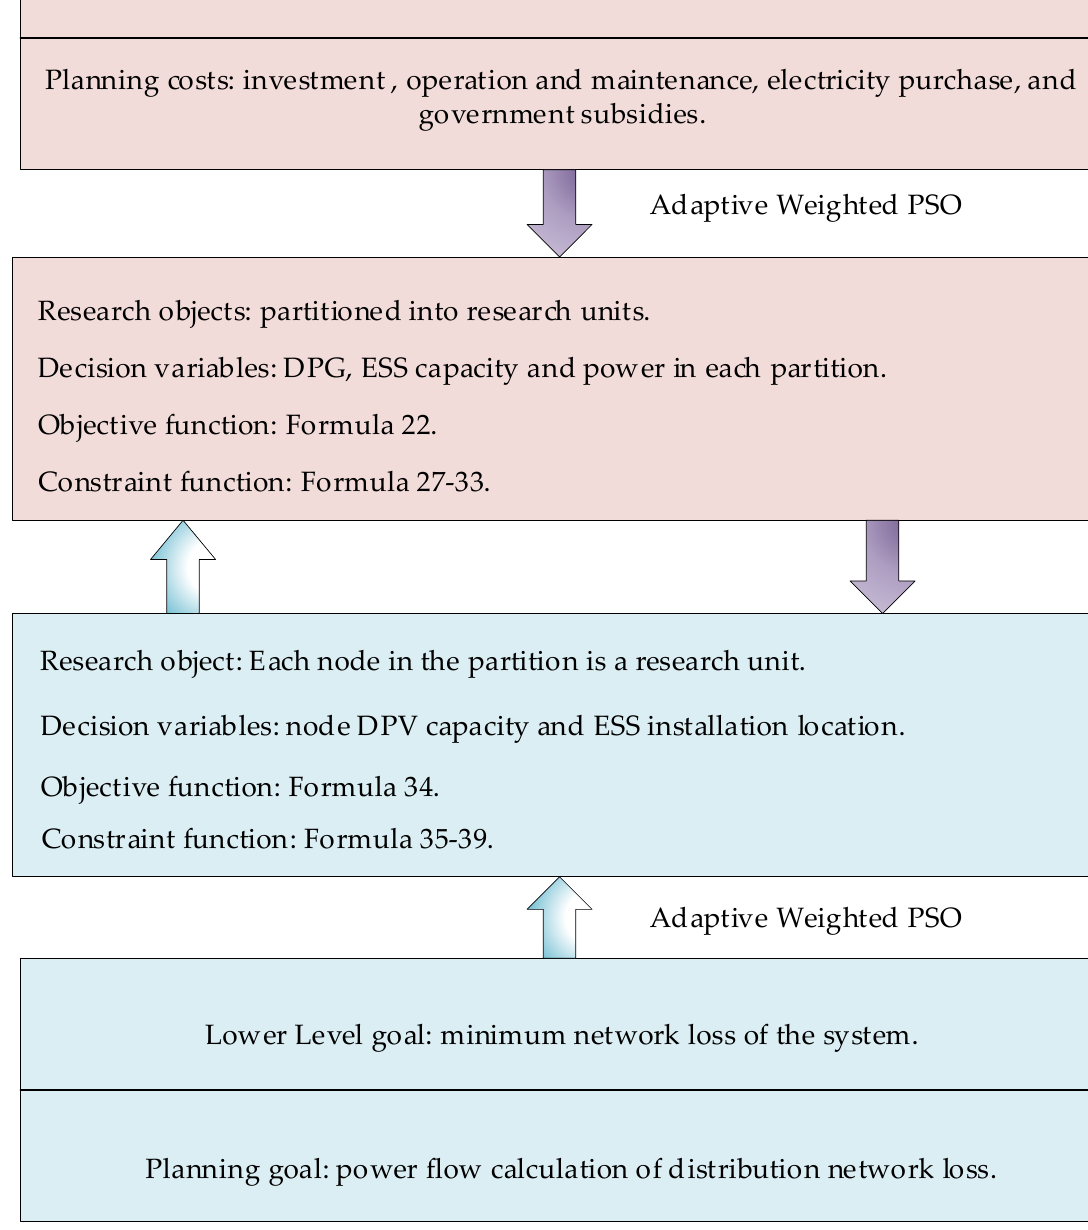
Figure 3. Photovoltaic energy storage bilevel programming model.